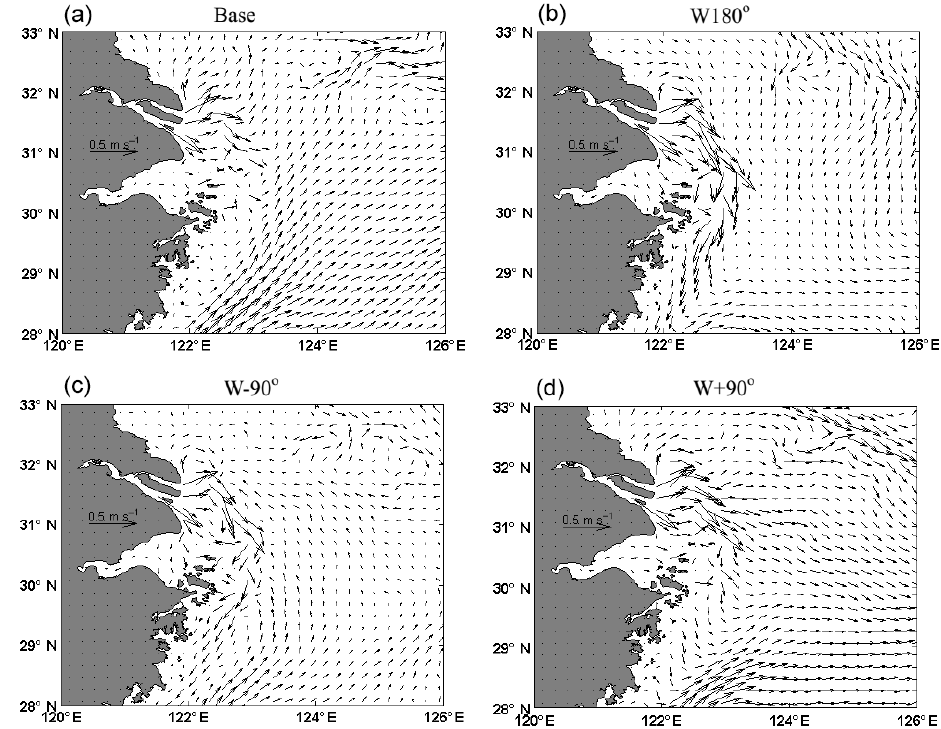
Figure 15. Circulation pattern in the surface water: (a) base model run; (b) W 180 ◦ ; (c) W − 90 ◦ ; (d) W + 90 ◦ .